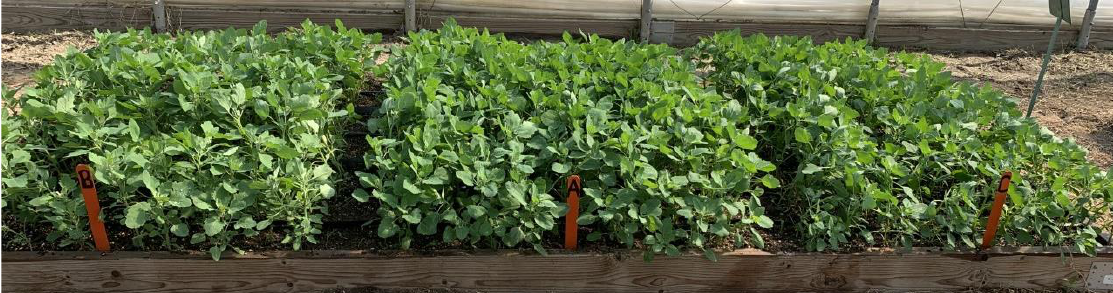
Figure 1. Five-week-old leafy greens of three varieties of quinoa at Lincoln University Carver farm, May 2022.